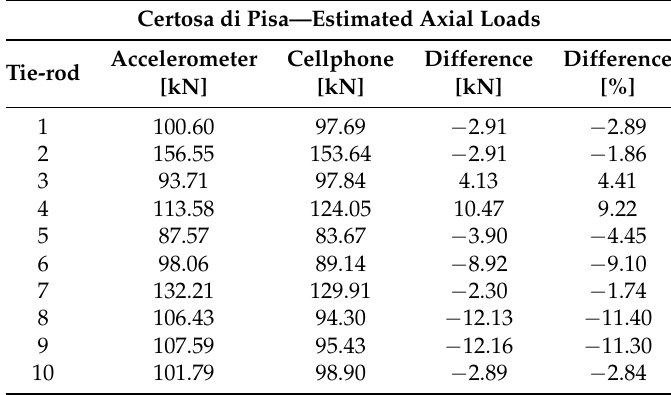
Table 3. Accelerometer-Cellphone comparison: axial load estimates for the ten tie-rods in the Certosa di Pisa obtained with frequency measures from an accelerometer, or from the cellphone